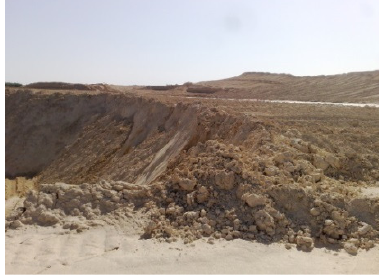
Fig. 2. Unused dolomite waste sand Table 1. Chemical composition of